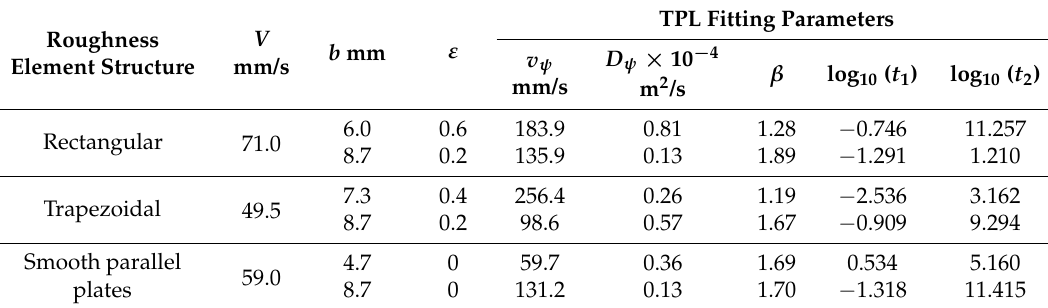
Table 9. As a reference for comparison, BTCs at position x = 355 mm downstream, V of 59.0 m/s, and b of 4.7 mm and 8.7 mm in single fractures with smooth parallel plates were also fitted by the CTRW TPL and the results are also listed in Table 9. Table 9. Fitting results of TPL for single fractures with different ε and b